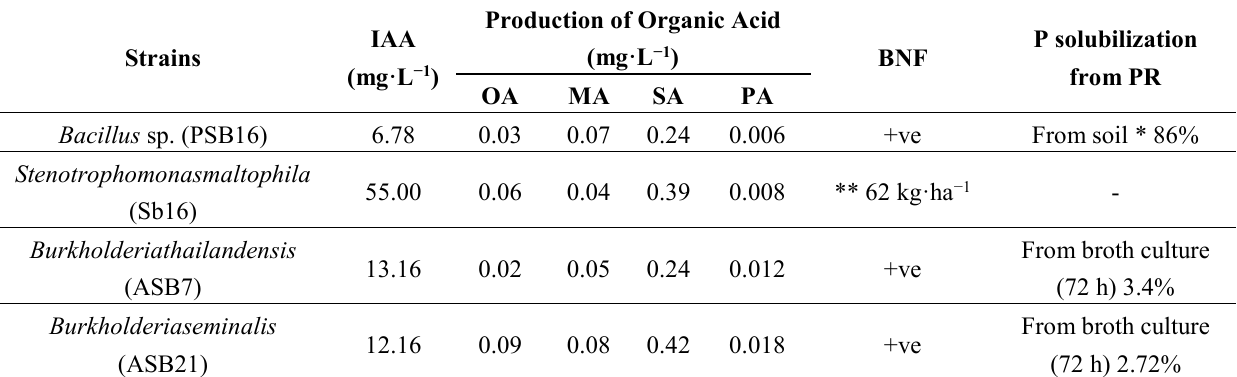
Table 1. Bio-chemical properties of the bacterial strains.